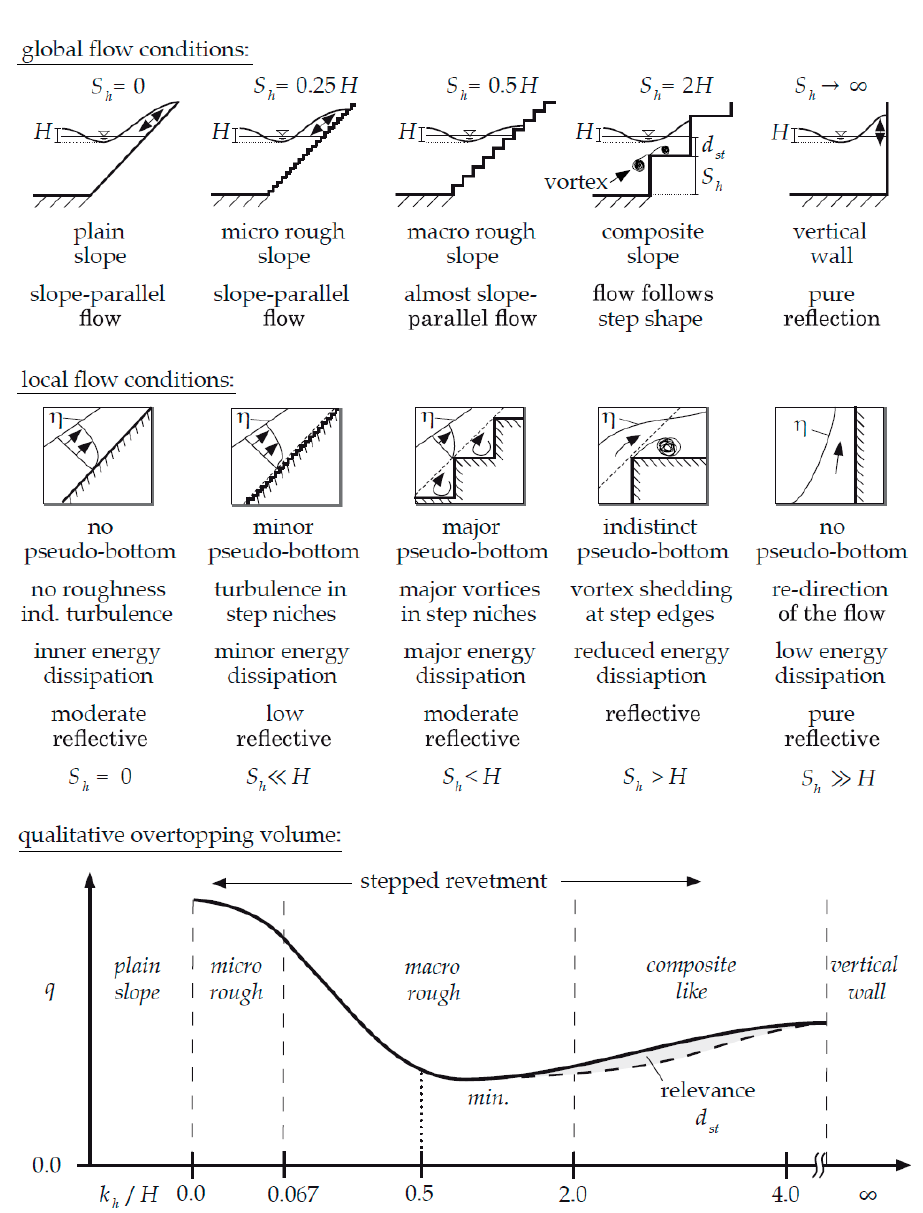
Figure 5. Dependence of the step ratio on the wave run-up and wave overtopping.